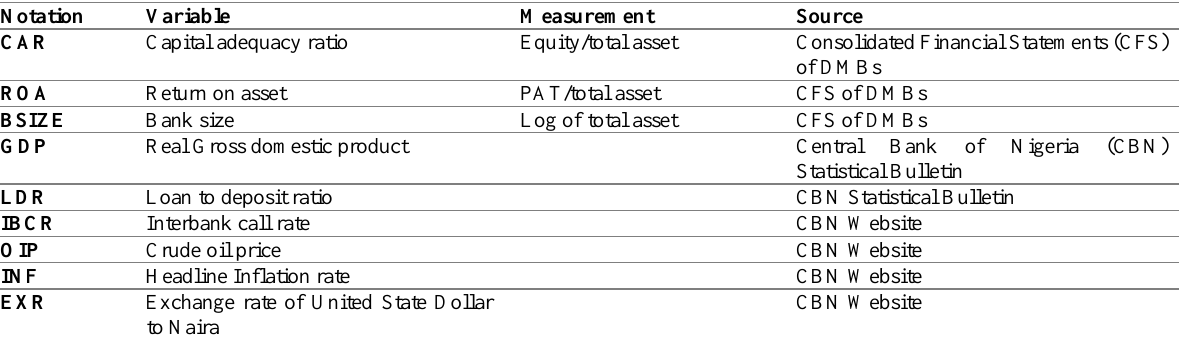
Table 1: Variables, Measurement and